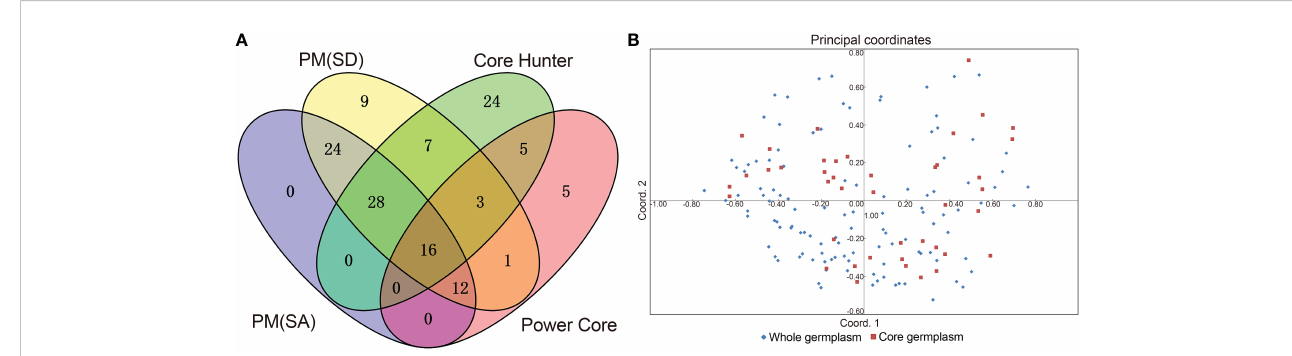
FIGURE 5 Venn diagram and Principal component plot. (A) Venn diagram of core collections de fi ned by four methods, including SANA method-PM (SA) and SAGD method-PM (SD), Core Hunter, and Power Core (Mp method), and (B) Principal component plot between the core and entire collections based on 40 polymorphism EST-SSR molecular marker.